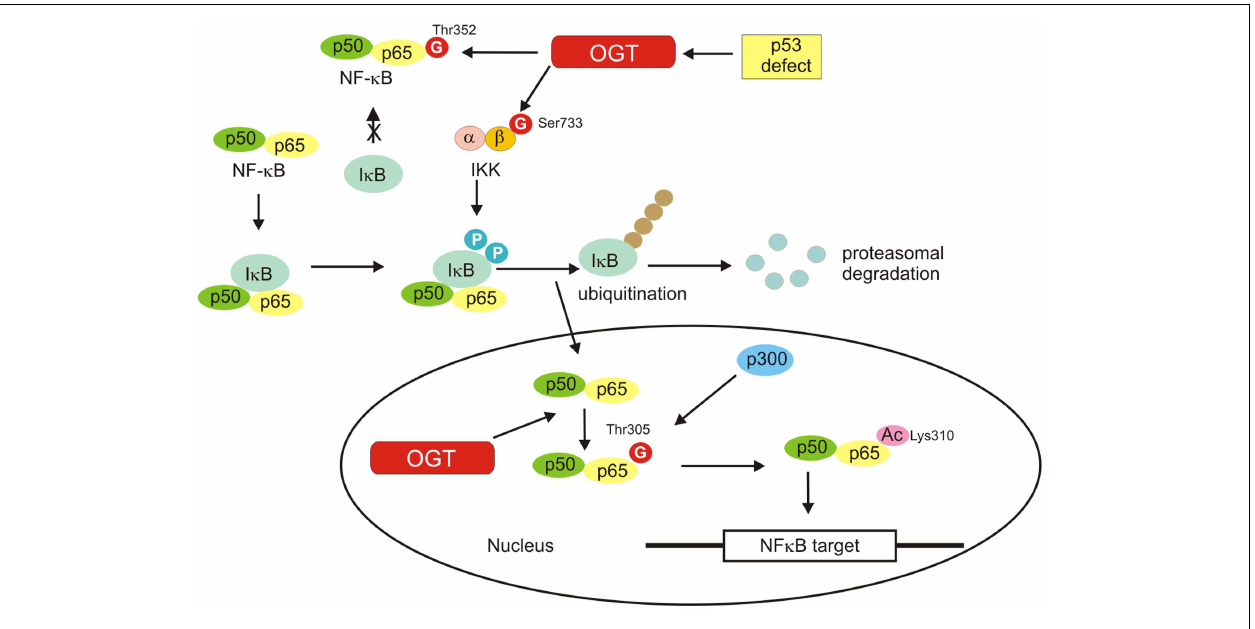
proteosome.The activated NF- κ B is then translocated into the nucleus where it binds to specific sequences of DNA. O -GlcNAcylation favors activation of NF- κ B by regulation of IKK β activity, inhibition of the interaction of NF- κ B with IkB, and promotion of NF- κ B